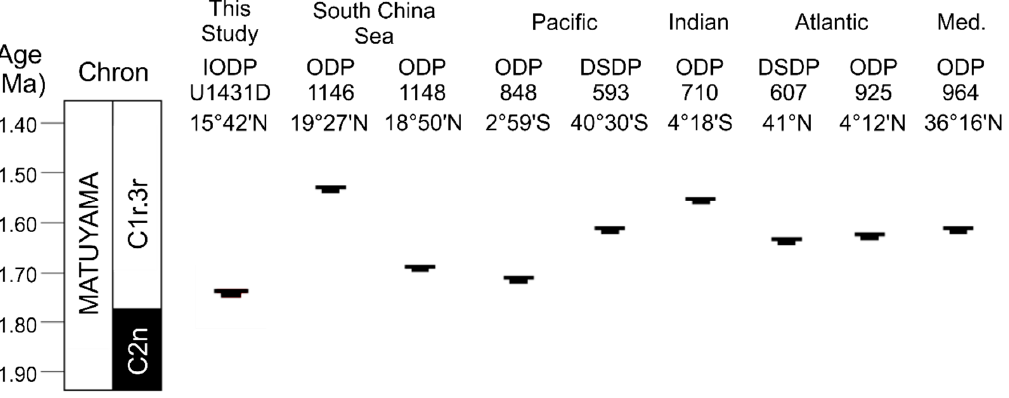
Figure 8. Comparison of stratigraphic ranges of the LO of Calcidiscus macintyrei from IODP/ODP/DSDP Sites. Magnetostratigraphic records from IODP Site U1431D, ODP Sites 1148, 848, 710 and DSDP Site 593 are calibrated to the astronomically tuned Geomagnetic Polarity Time Scale (GPTS) of [61] as compiled by [9]. Oxygen isotope data is used to determine the ages in ODP Sites 1146, 925, 964 and DSDP Site 607. These datums are calibrated to the benthic foraminiferal δ 18 O time scale of [2]. Horizontal bars represent the recalculated datum ages for each site. Med.—Mediterranean. Black—normal; white—reversed polarity.